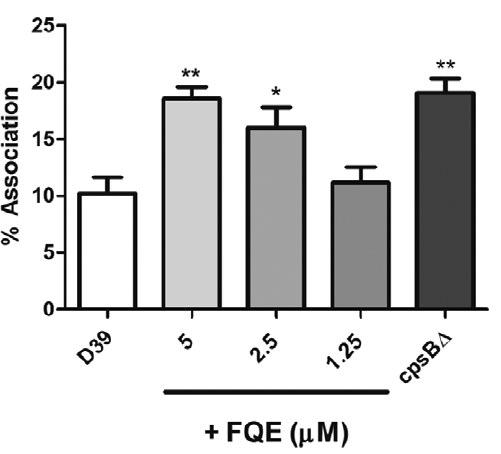
Figure 5. FQE increases attachment of D39 to macrophages. D39 was incubated with FQE and then assessed for its ability to associate with RAW 264.7 cells as described in Materials and Methods. Data is presented as % association relative to inoculum. D39 cpsB ? was used for comparison purposes. Results are from three independent experiments (** - P , 0.01; * - P , 0.05 compared to D39 by Student’s t - test).